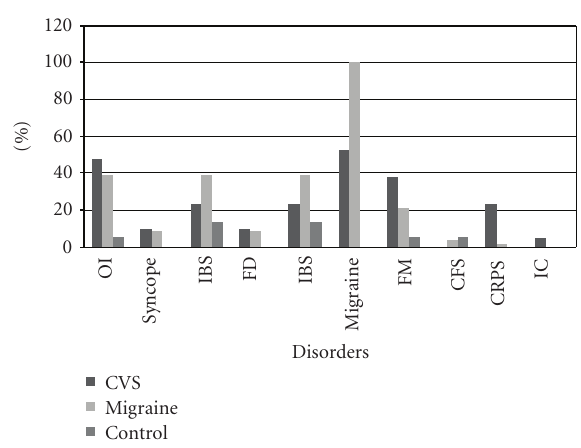
Figure 1: The range of autonomic co-morbidities in cyclic vomiting syndrome, migraine and healthy control